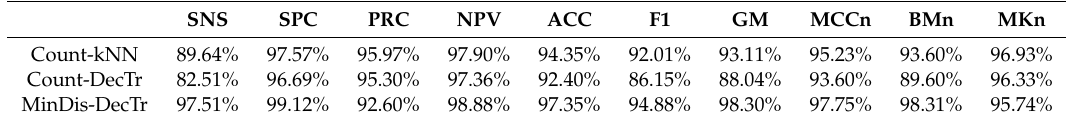
Table 8. Performance metrics for three pairs of (score, frame) classifiers.